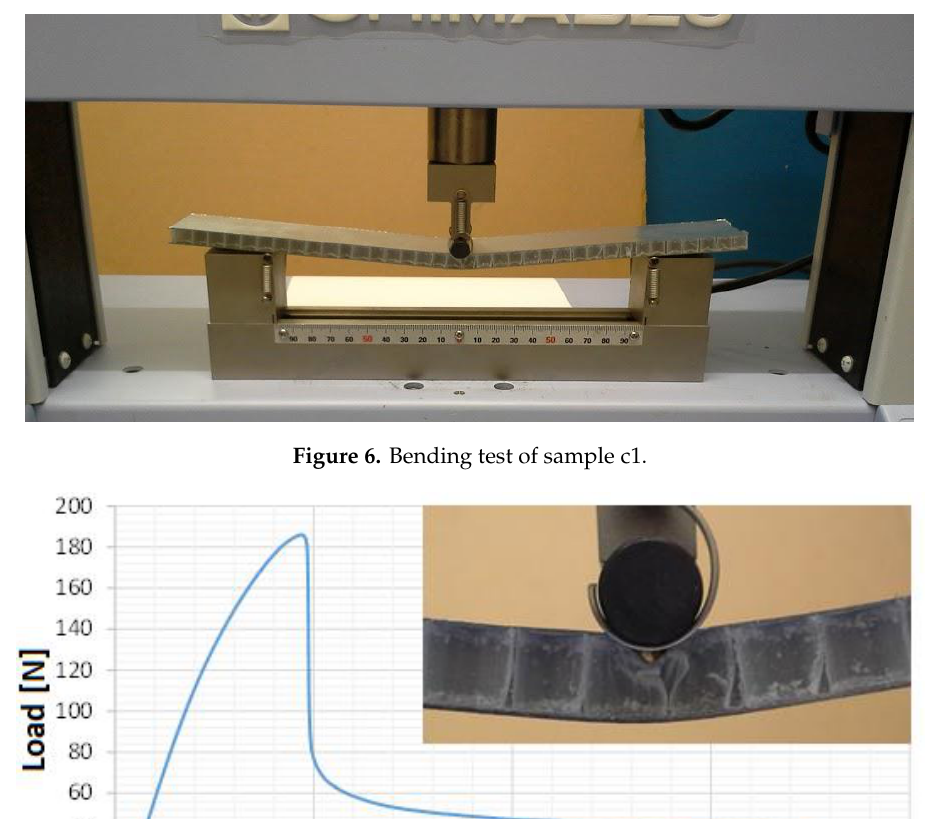
Figure 5. Sample c1 prior testing.